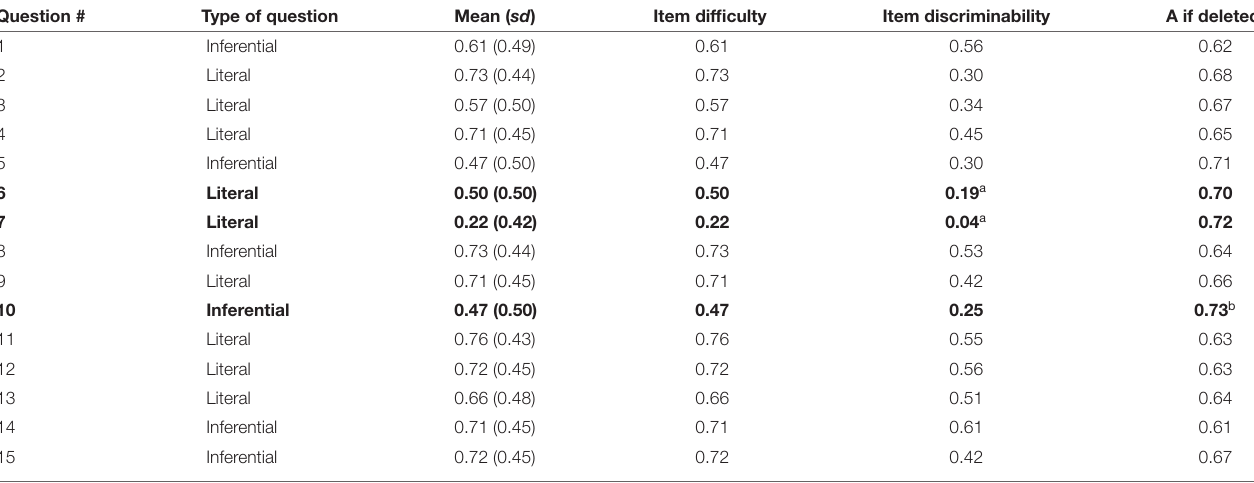
TABLE 1 | Item difficulty and discrimination of the questions in ASL-Text Comprehension Task.